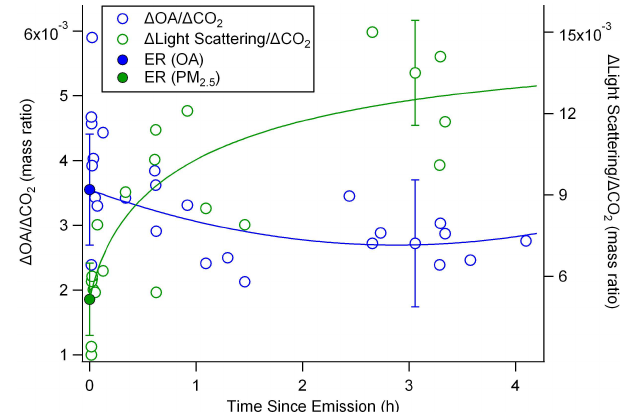
Fig. 11. 1 Light scattering/ 1 CO 2 (green) and 1 OA/ 1 CO 2 (blue) mass ratios are shown vs. time since emission (h). ER(PM 2 . 5 ) (solid green circle) and ER(OA) (solid blue circle) are shown with er- ror bars depicting the standard deviation in the mean of the ten source measurements. We show all the source samples to illus- trate the variability in the source measurements. The log-normal ( 1 light scattering/ 1 CO 2 ) and second order polyfit ( 1 OA/ 1 CO 2 ) trendlines shown best correlate with the data. Error bars shown on downwind samples are an estimate of the uncertainty in individual downwind samples. 1 Light scattering/ 1 CO 2 is shown converted to the mass ratio 1 PM 2 . 5 / 1 CO 2 under the assumption that the ra- tio between b scat and PM 2 . 5 is constant with time since emission. The assumption that the conversion between b scat and PM 2 . 5 is con- stant with smoke age would imply an unrealistic 1 OA/ 1 PM 2 . 5 of < 25% at a plume age of 4h. The increase in light scattering dur- ing the first 1.5h since emission is probably due to particle growth via coagulation and then chiefly by condensation soon thereafter (Sect.